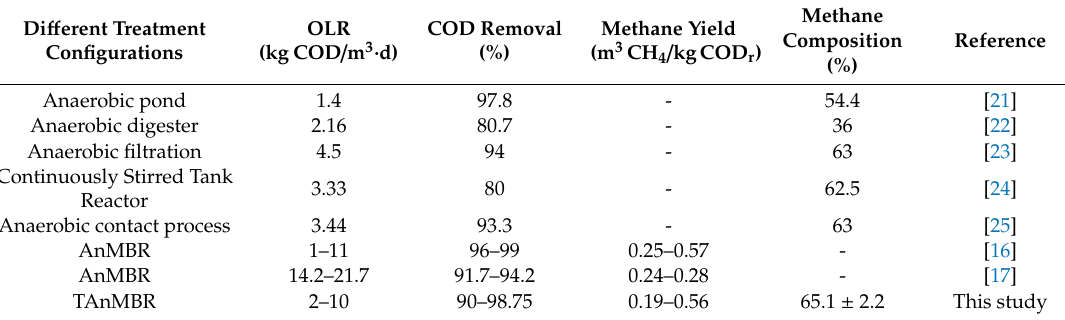
Table 3. Different anaerobic POME treatment methods and their performance. Table 3. Di ff erent anaerobic POME treatment methods and their performance.